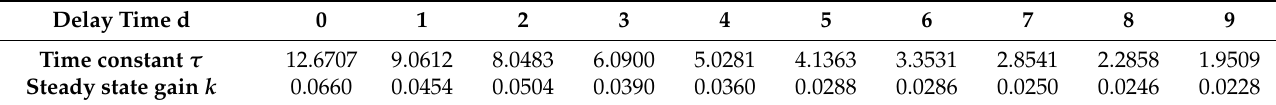
Table 3. Identification results of τ and k for heading loop with different delay time parameter d.